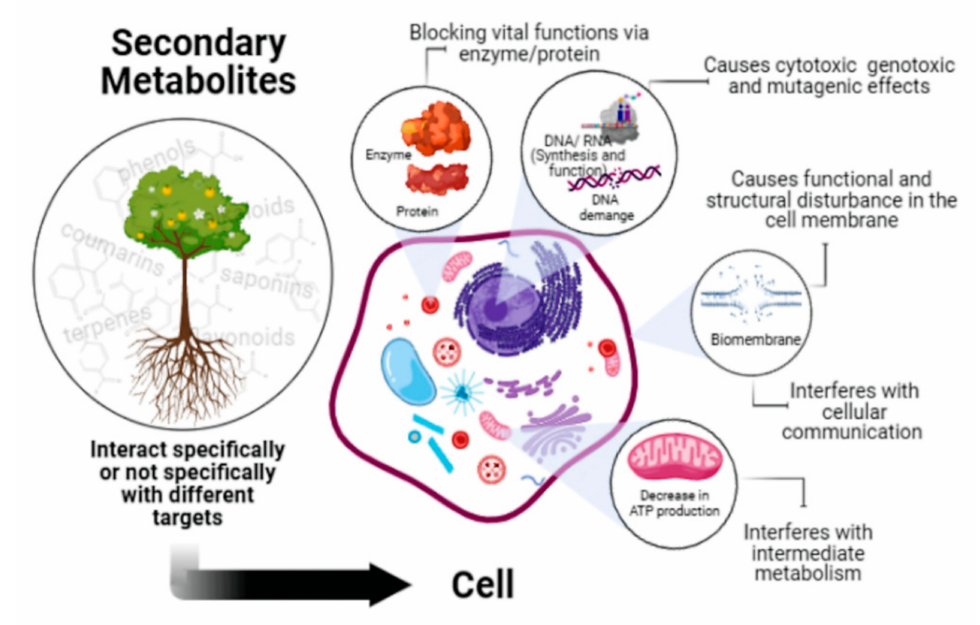
Figure 6. Mechanisms of action of secondary metabolites with cytotoxic effects. Secondary metabo- lites can interact specifically or not specifically with biomolecules, biomembranes, and other cellular components, disturbing the vital components of the